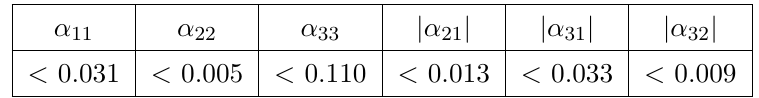
Table 1 . 90% confidence level (C.L.) limits on the NUNM parameters using data from various short-baseline and long-baseline experiments, as obtained from the ref.